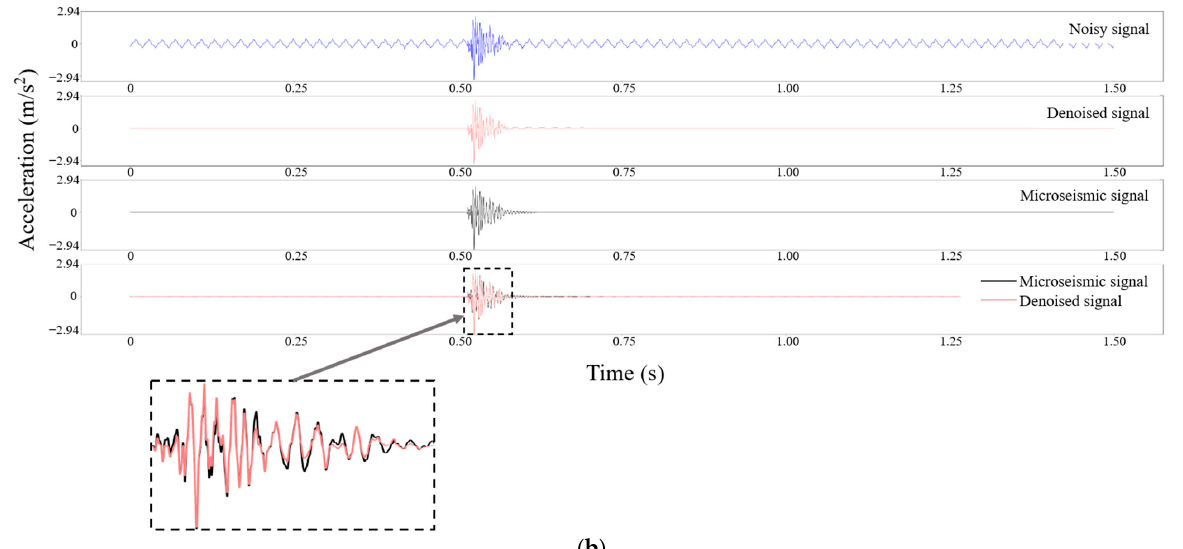
Figure 3. ( a ) Maximum amplitude difference distribution between noise and predicted noise. ( b ) The contrast diagram of the waveform of the PDTN denoised microseismic signal and the waveform of the clean microseismic signal. From top to bottom, the noisy signal (composed of the original clean microseismic signal and noise), PDTN denoised microseismic signal, clean microseismic signal, comparison between the PDTN denoised microseismic signal and the clean microseismic signal, and the local magnification.